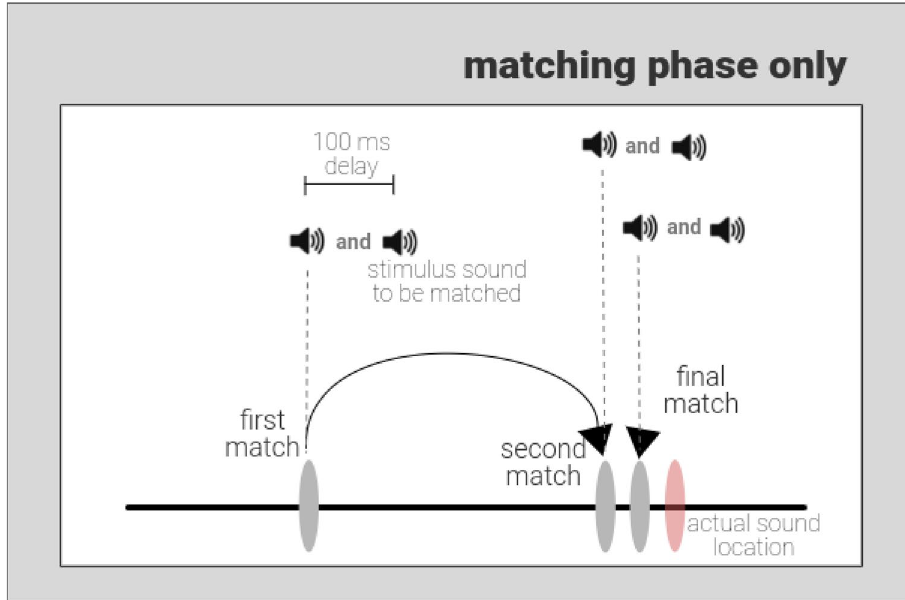
Figure 3. Perceptual precision experiment. In comparison to Experiment 1, there is only a matching phase. The stimulus (auditory trial shown here) to be matched is presented 100 ms after a match is made on the scale and so each click on the scale produces two sounds in a sequence. The first is the sound at the parameter location of the click and the second is the sound to match to. Participants are asked to click multiple times on the scale (hence, ‘first match’, ‘second match’ and ‘final match’) until they find a point where the two sounds in succession sound the same. In this auditory trial, the light red ellipse indicates the true location of the sound parameter to be